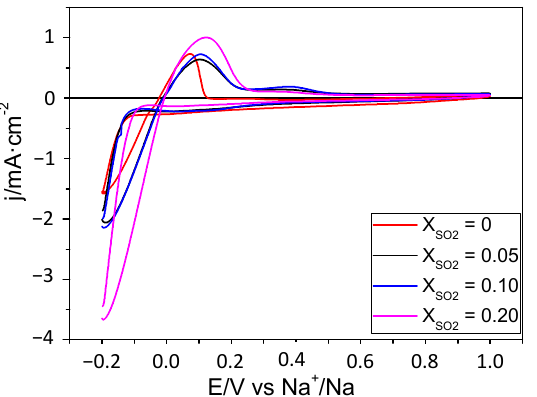
Figure 4. CVs for the deposition of Na on Cu in 1 M NaClO 4 /PC at 20 mV s − 1 for several SO 2 concentrations.